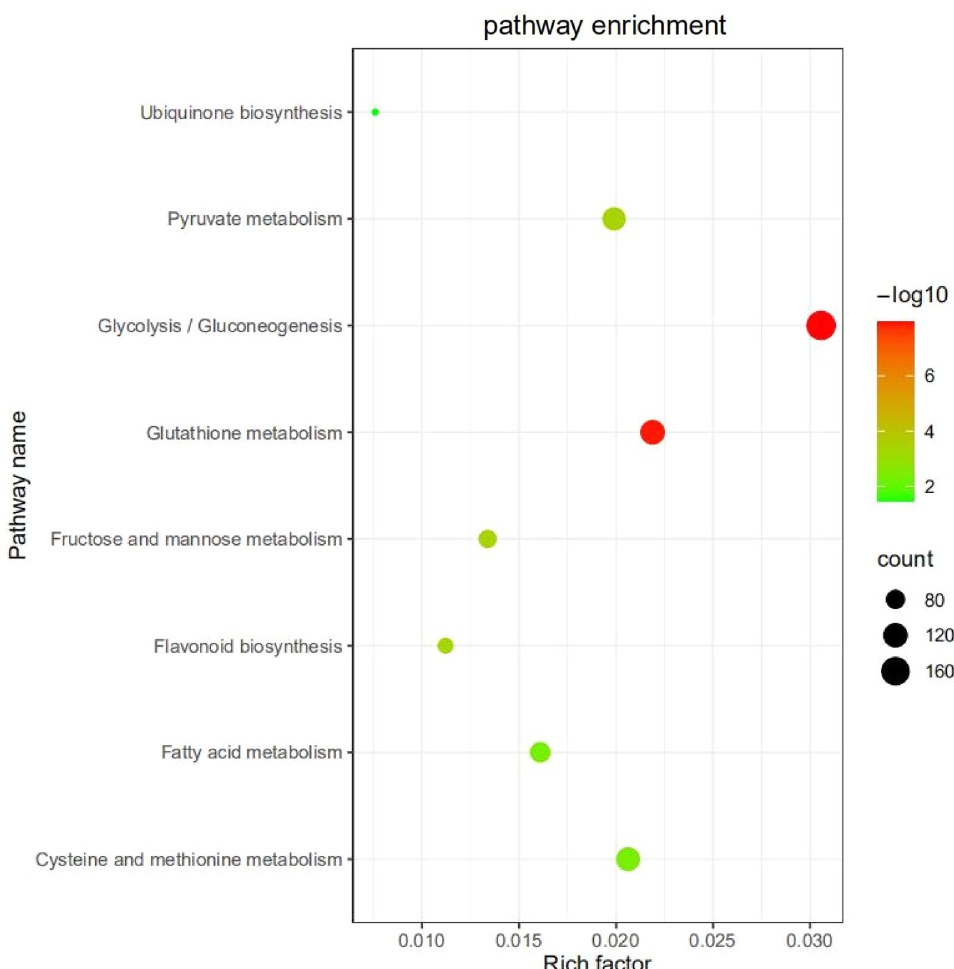
Figure 5. Analysis of KEGG pathways enrichment. Each circle in the diagram represents a KEGG metabolic pathway, and the size of the circle corresponds to the number of genes enriched in that pathway. The importance of DEG enrichment in a pathway is represented by the − log 10 scale